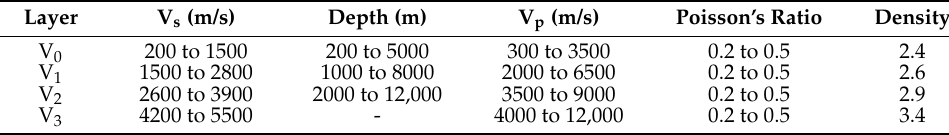
Table 1. Parameterization for